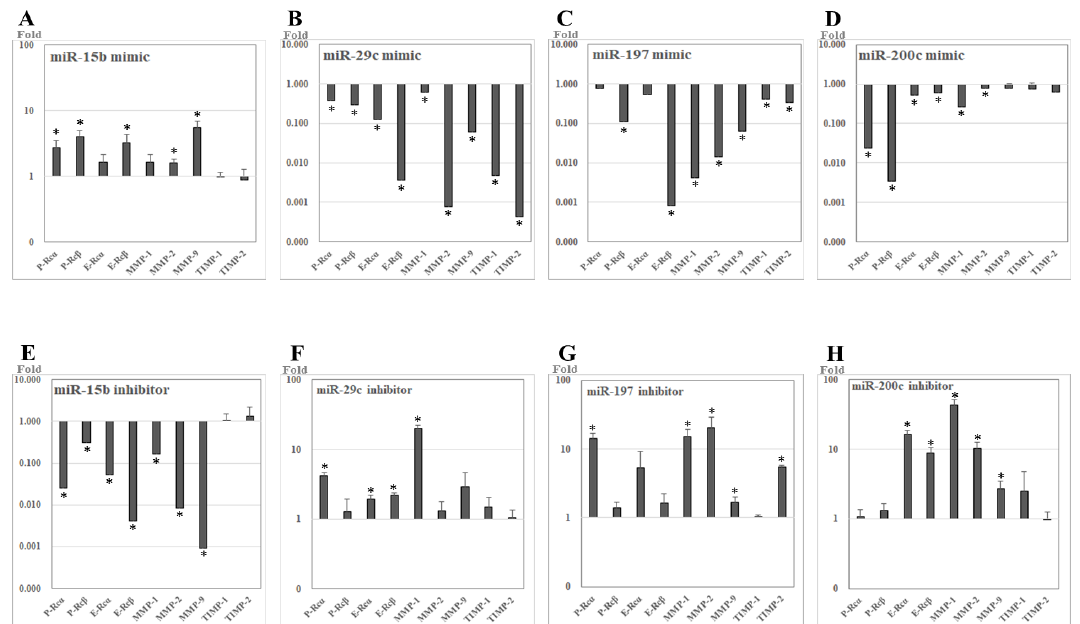
Figure 5. The relative expression of candidate target genes of studied miRNAs after transfection with miRNA analogues into leiomyoma cells cultured in vitro (RT-PCR). ( A – D ) miR-mimics. ( E – H ) miR-inhibitors. * p <0.05.